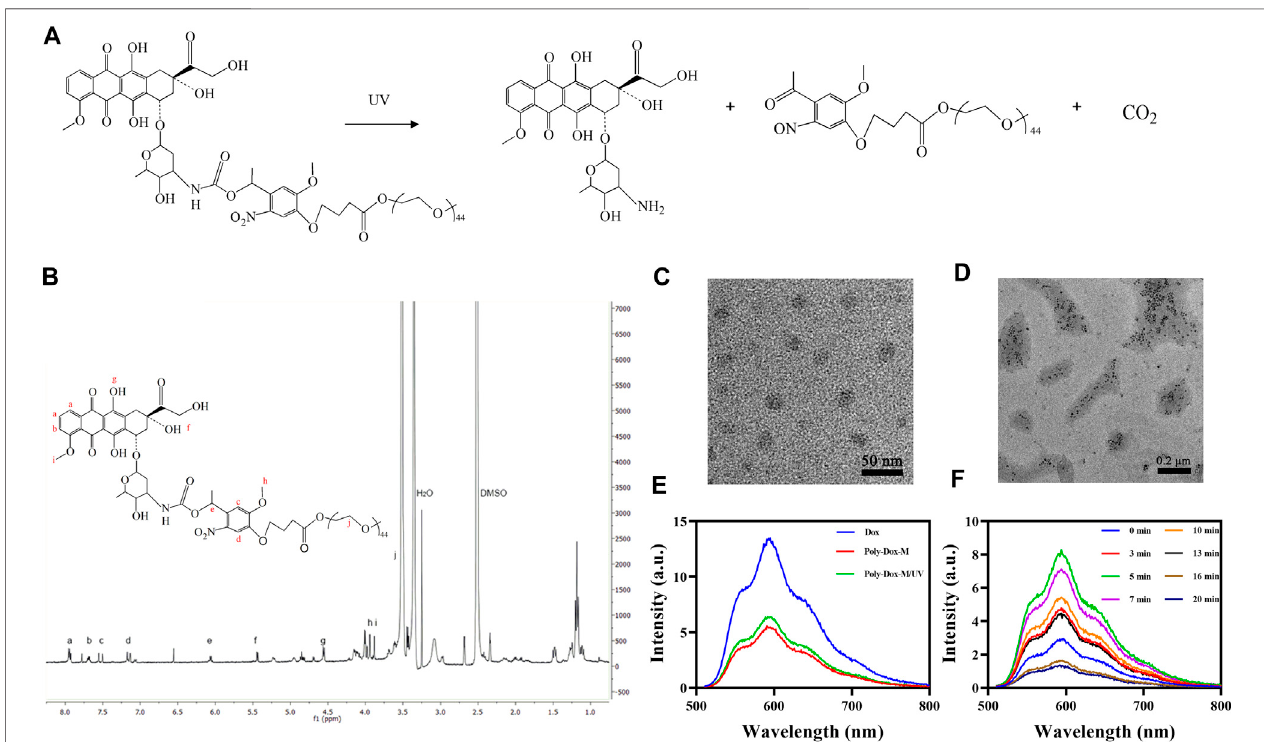
FIGURE 1 | (A) Detailed depolymerization routes of Poly-Dox copolymer drug conjugates. (B) 1 H-NMR spectra of Poly-Dox in DMSO-d6. (C) TEM image of Poly- Dox-M. (D) TEMimageofdisassembledPoly-Dox-MafterUVirradiation. (E) FluorescenceintensityofFree-Dox,Poly-Dox-M,andPoly-Dox-M/UV. (F) The fl uorescence intensity changes of Poly-Dox-M after UV irradiation of 0, 3, 5, 7, 10, 13, 16, and 20 min.